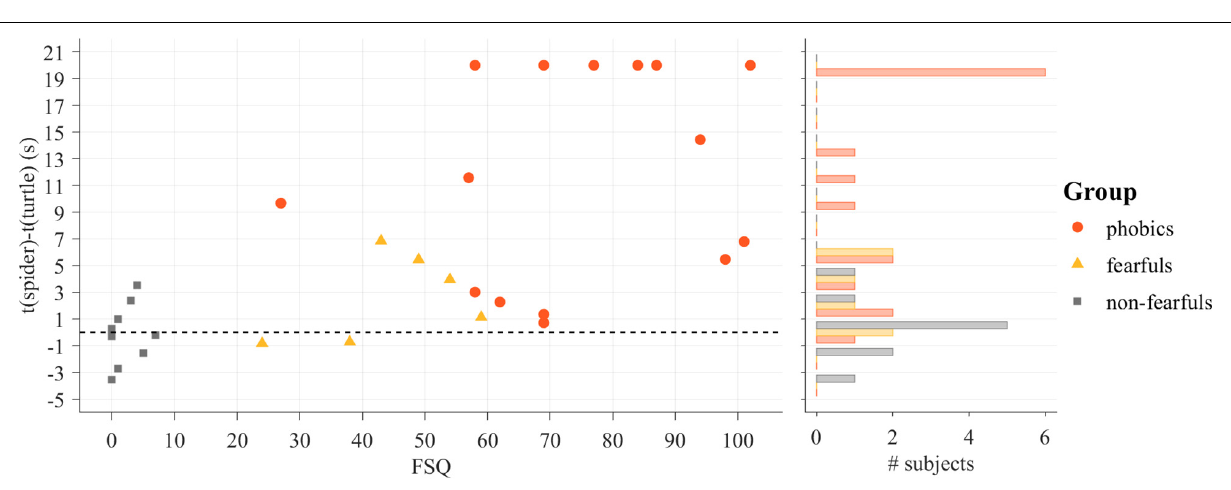
or group × stimulus × trial [ F (2,28) = 0.84, p = 0.44, η 2 η 2 = 0.01] were observed. The number of changes in acceleration G by stimulus and group is depicted in Figure 9